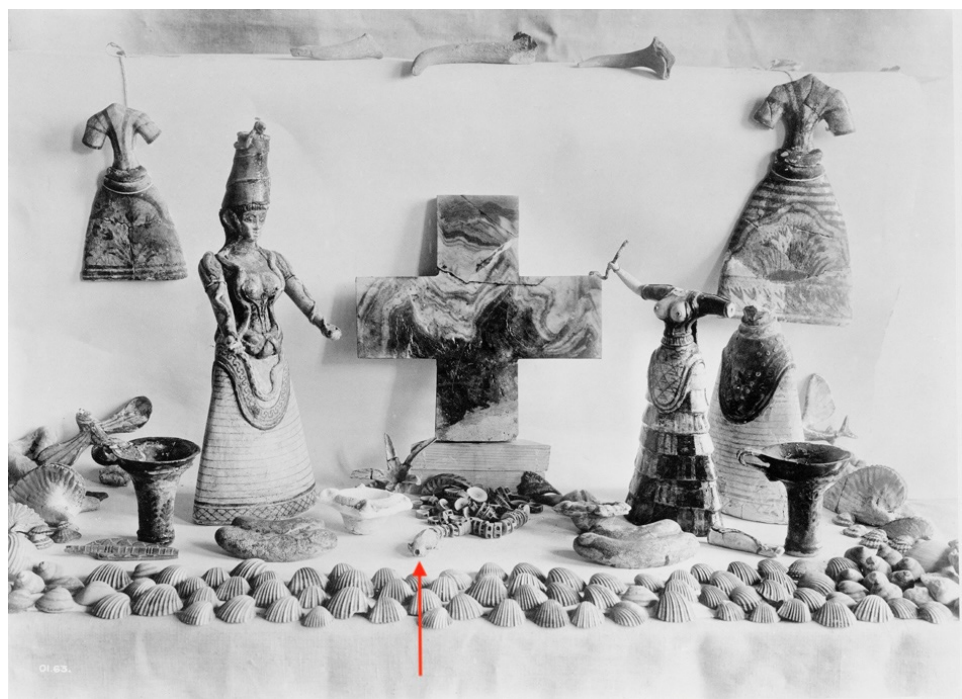
Figure 5. Finds from the Temple Repositories of the Palace of Knossos (c. 17th c. BCE), including the weasel skull indicated by the arrow, as arranged by Arthur Evans shortly after discovery. Courtesy of the Ashmolean Museum Archive Collections, Oxford.